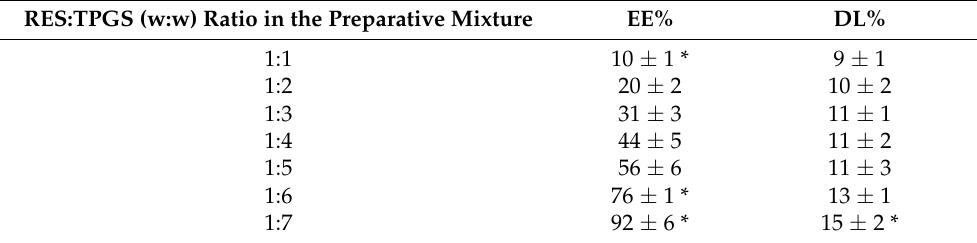
Table 1. Encapsulation efficiency (EE%) and drug loading capacity (DL%) of different RES-TPGS formulations. Each value represents the mean ± standard deviation ( ± SD) (degrees of freedom =